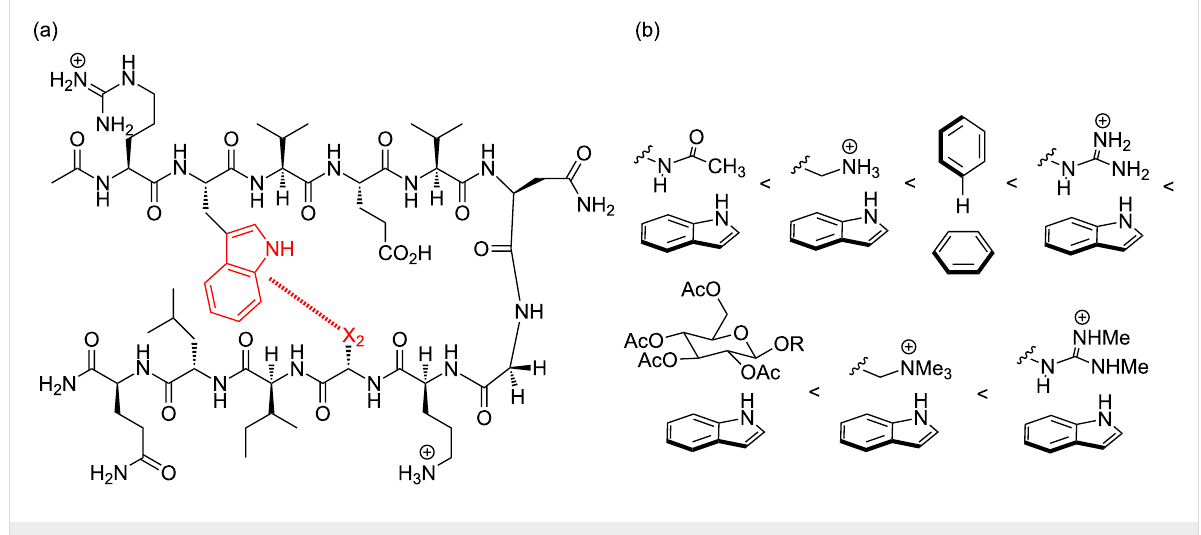
Figure 4: (a) Model β -hairpin for investigation of aromatic interactions. (b) Examples of noncovalent interactions studied, from weakest to strongest [16-32].